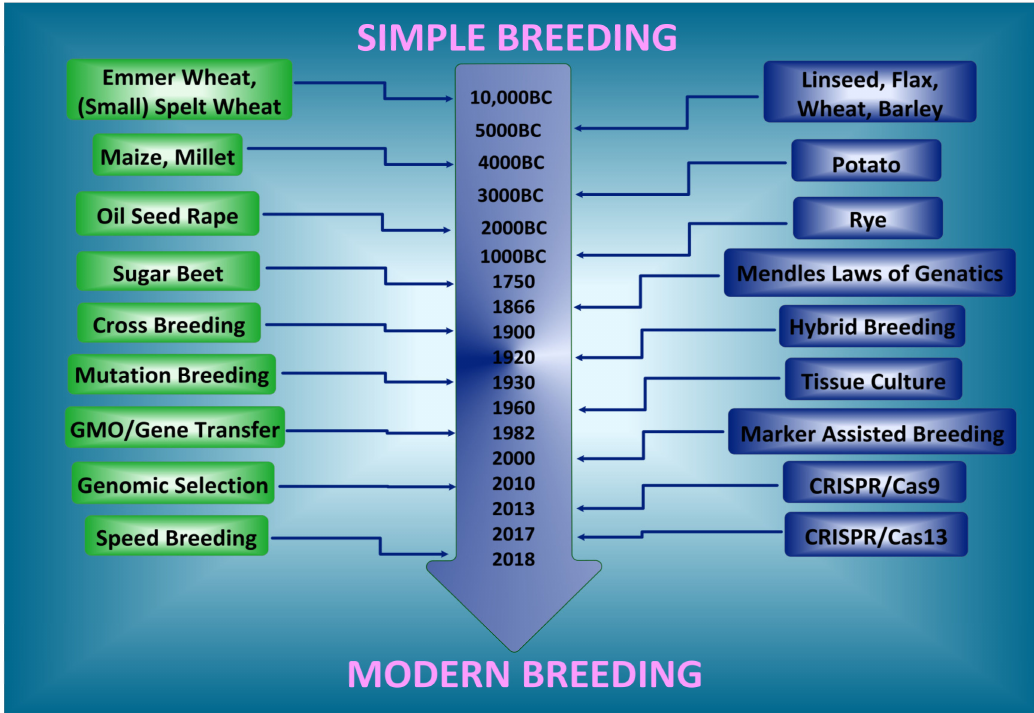
Figure 1. Historical milestones in plant breeding. For 10,000 years, farmers and breeders have been developing and improving crops. Presently, farmers feed 10 times more people using the same amount of land as 100 years